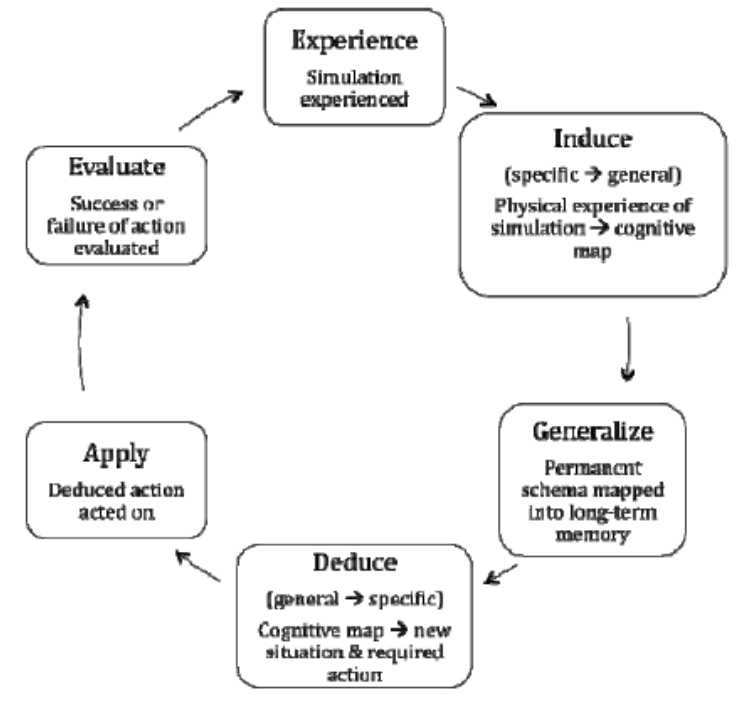
Fig. 3. Hahn’s (2010) cycle of experiential learning and transfer from